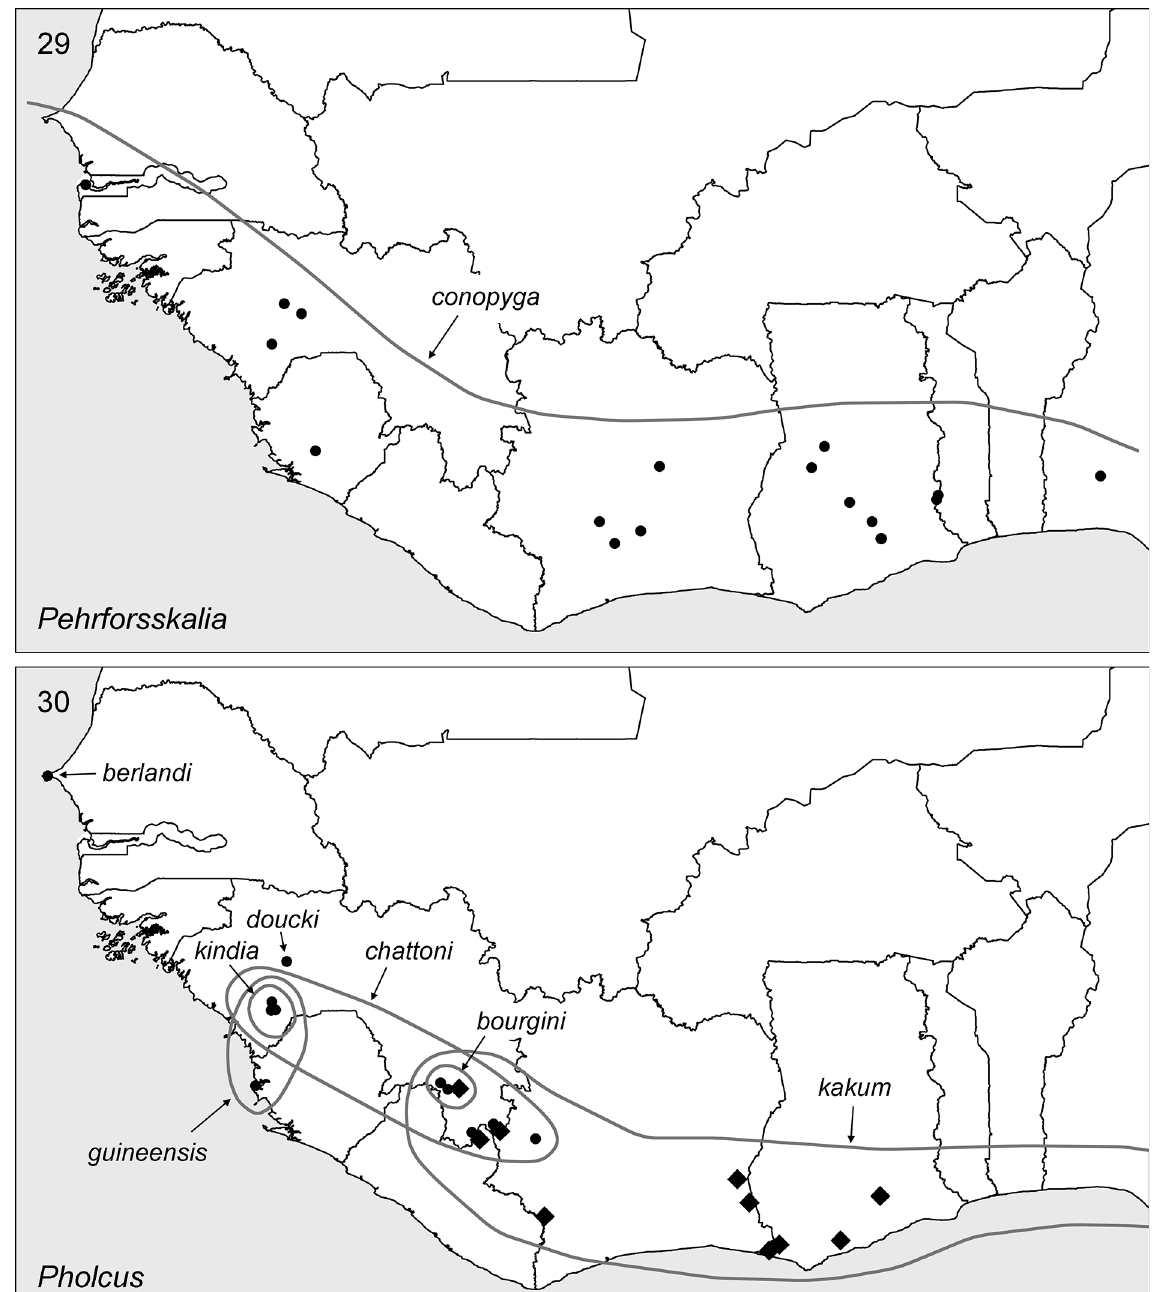
Figs 29-30. Known distributions of the genera Pehrforsskalia Deeleman-Reinhold & van Harten, 2001 and Pholcus Walckenaer, 1805 in West